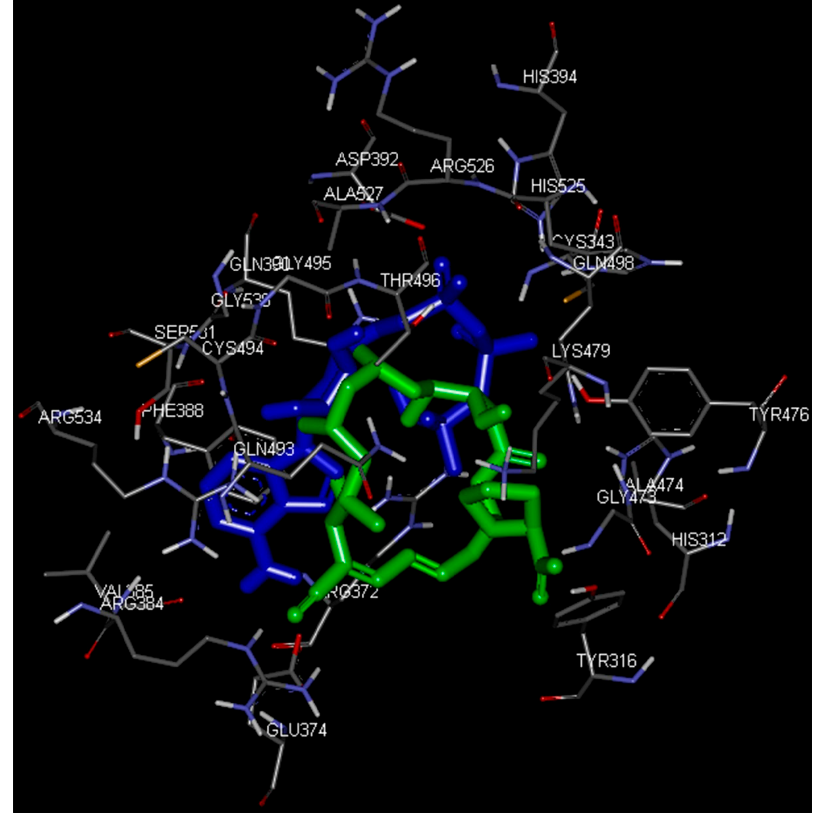
Figure 5. Predicted binding mode of ATP (blue) and borrelidin (green), as determined by docking of the ligands in the BaThrRS homology model.